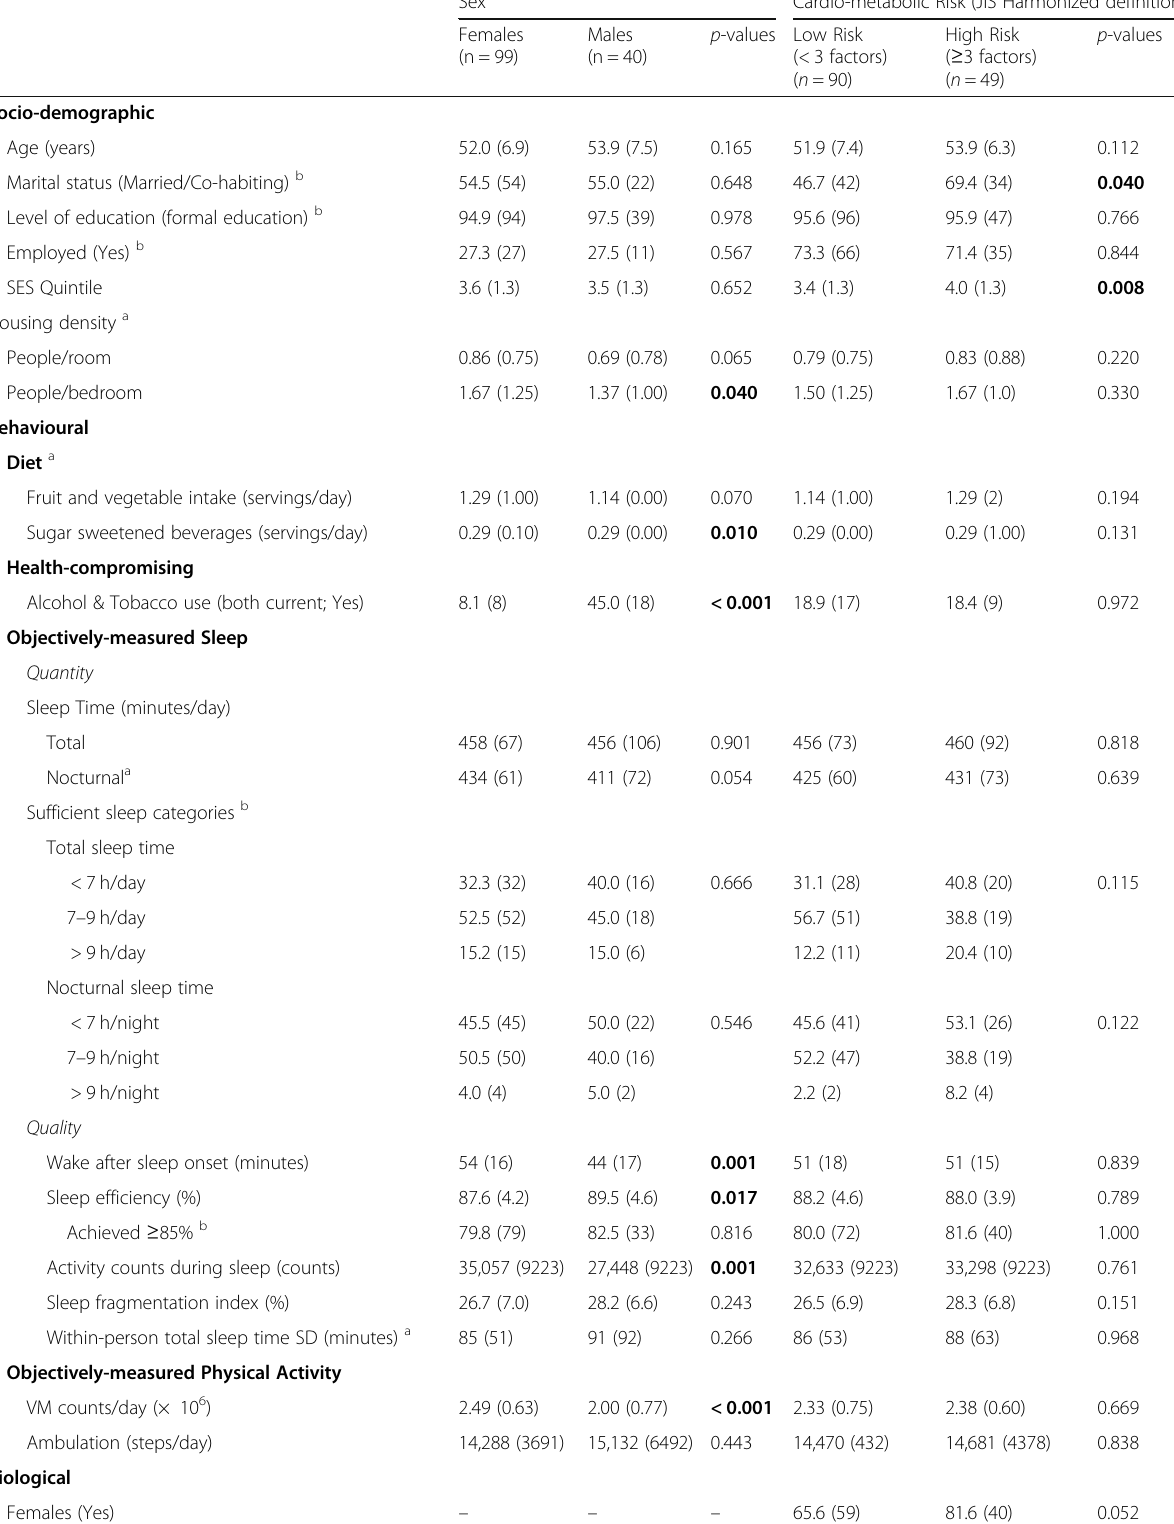
Table 1 Descriptive statistics of demographic, behavioural and biological characteristics by sex and cardio-metabolic risk